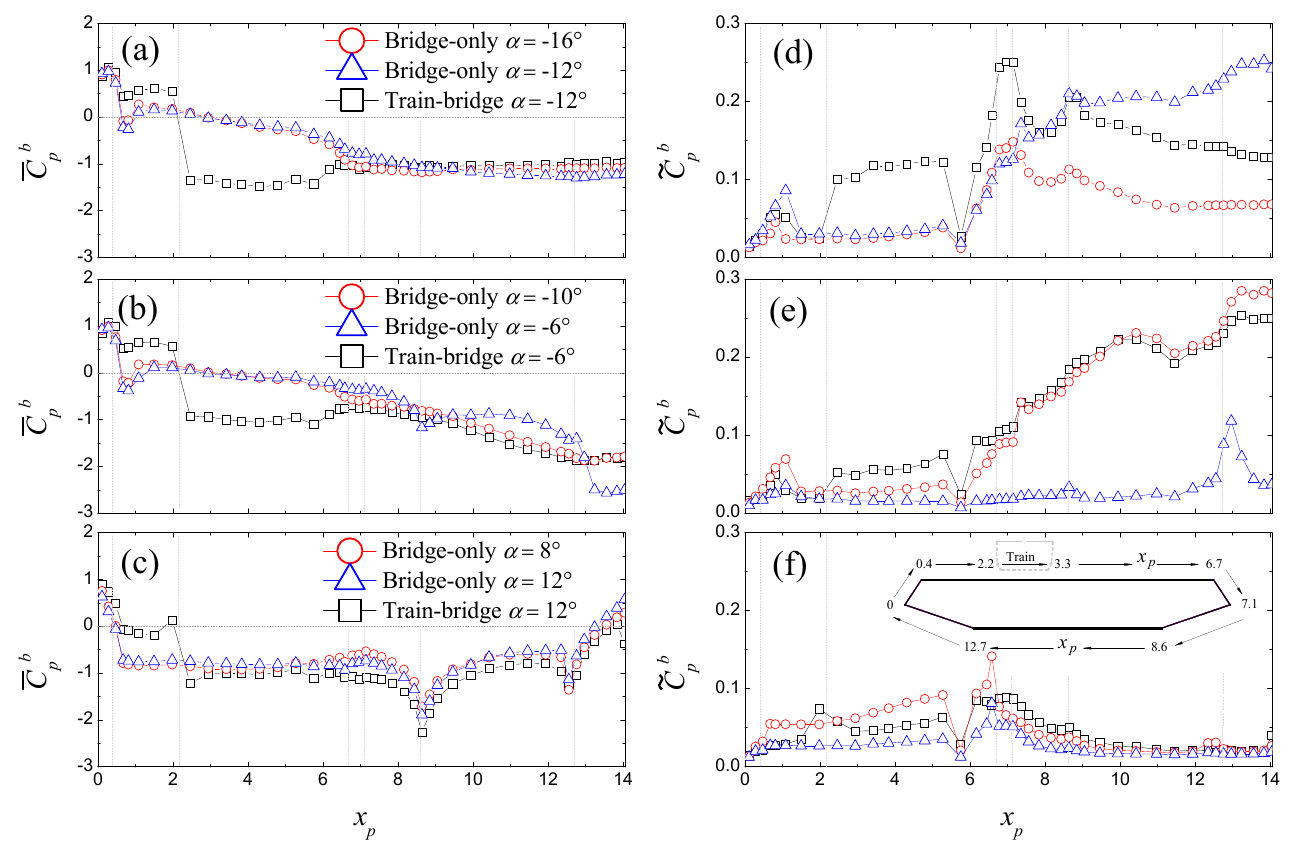
Figure 6. Pressure distributions around the bridge-deck model at various angles of attack: ( a – c ) Mean pressure coefficients; ( d – f ) Fluctuating pressure coefficients.